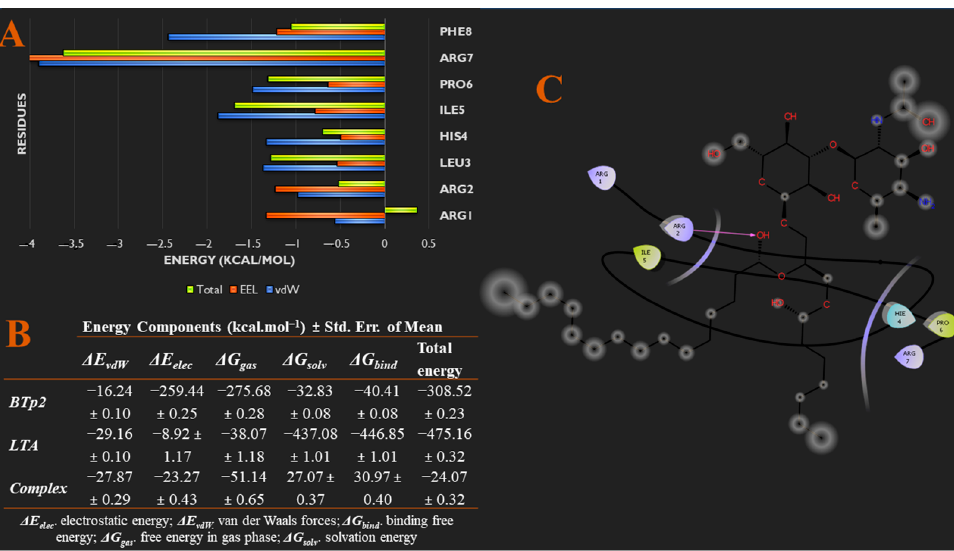
Figure 5. ( A ) Per-residue energy decomposition analysis showing specific energy contributions of each amino acid residue of BTp2 that contributes to binding. ( B ) Different energy contributions of each component of the system via MM/GBSA thermodynamics. ( C ) Binding interaction diagram of BTp2 to residues of TLR2.